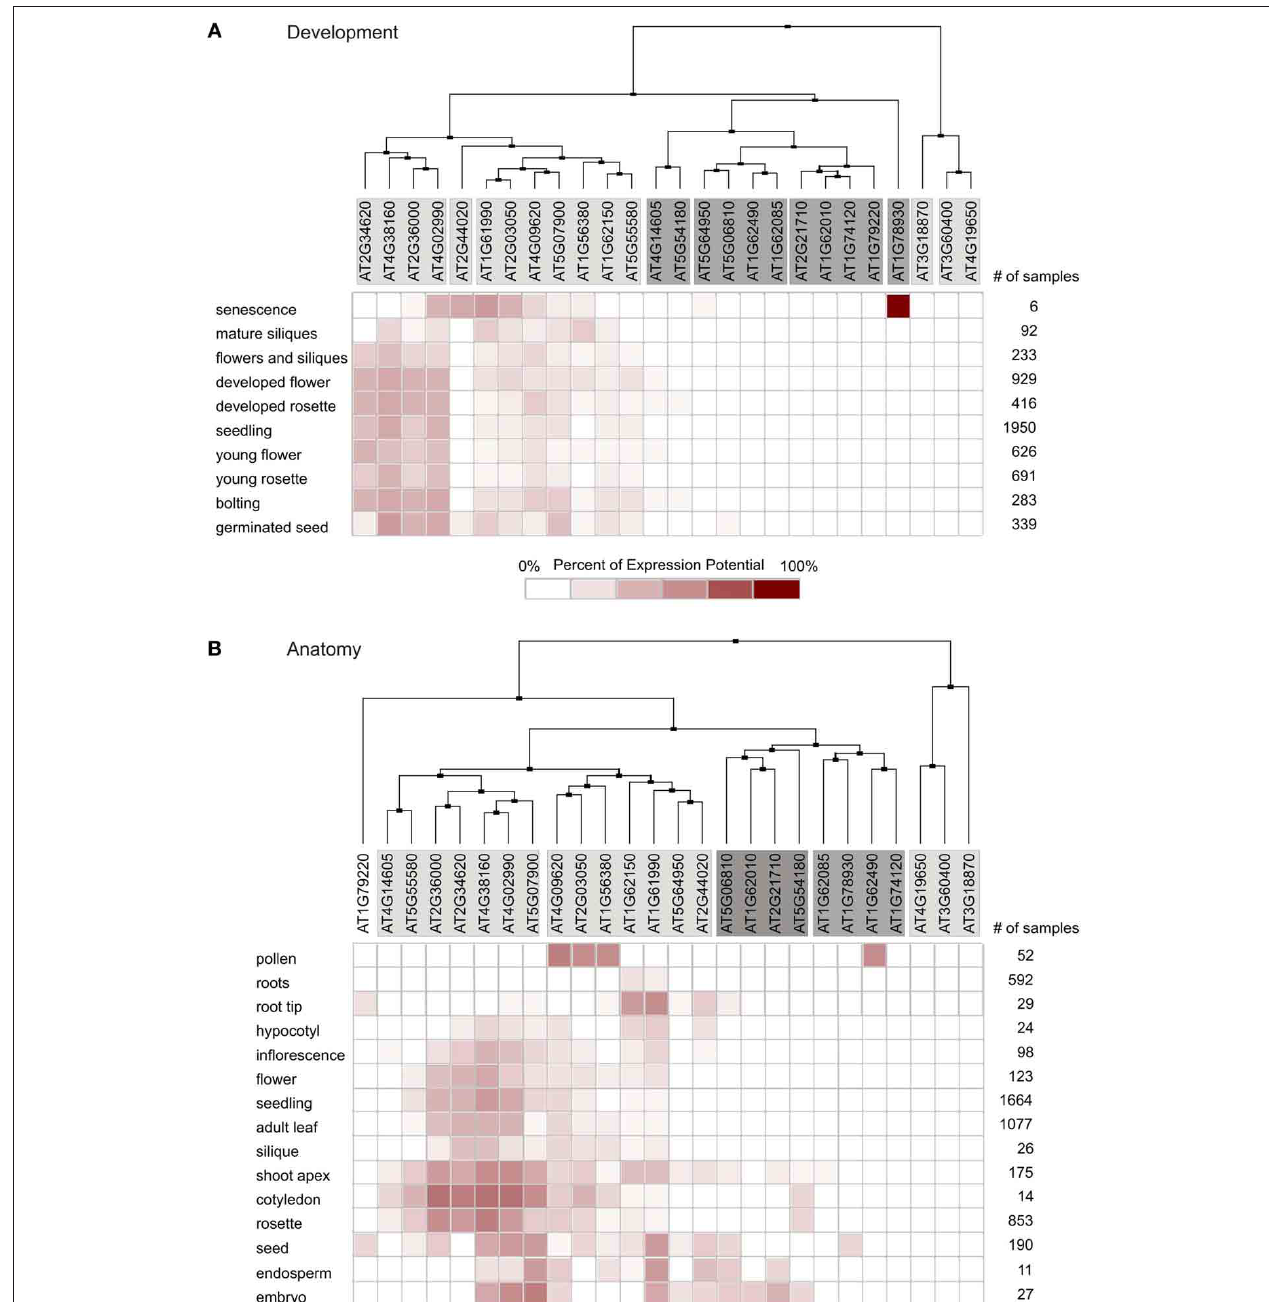
FIGURE 2 | Global expression profilingof MTERF genesin A.thaliana . ExpressionprofilesweredeterminedwiththeClusteringToolinGenevestigator. MTERF mRNAexpression data are shown for different developmental stages